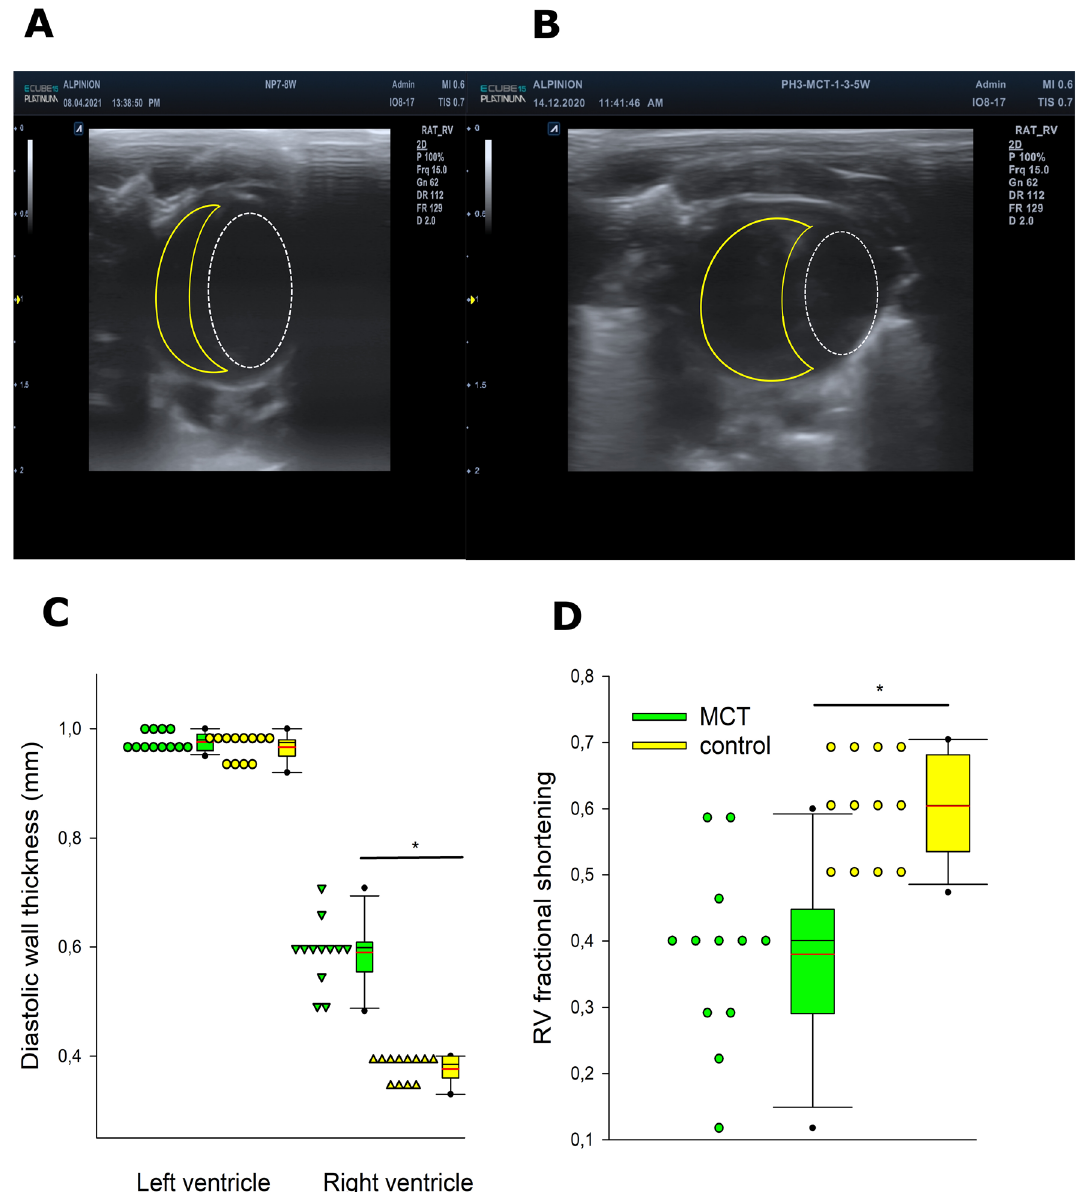
Figure 2. Echocardiographic characterization of rats with monocrotaline-induced pulmonary hypertension and normal rats. Short-axis view of the rat heart in control ( A ) and monocrotaline-treated ( B ) rats. Yellow line outlines contours of the right ventricular cavity, white line of the left ventricular cavity. Markedly dilated right ventricle and compressed left ventricle can be seen in monocrotaline-treated rats ( B ). Lower panels demonstrate right diastolic wall thickness ( C ) and ventricular fractional shortening ( D ). Horizontal lines represent mean (red) and median (black), the bottom and the top of the boxes represent the upper and the lower quartile, he whiskers represent 10th and 90th percentile, while the solid circles represent the individual data points. Control n = 12; MCT n = 12; since the data exhibited non-normal distribution, the groups were compared using Mann– Whitney test;* p <